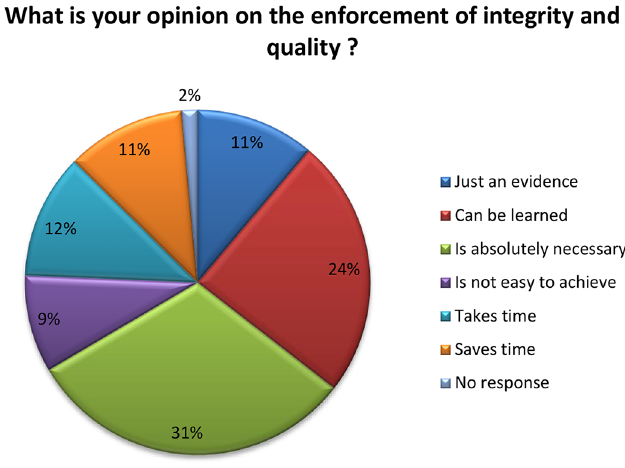
Fig. 4. General opinion on research integrity and